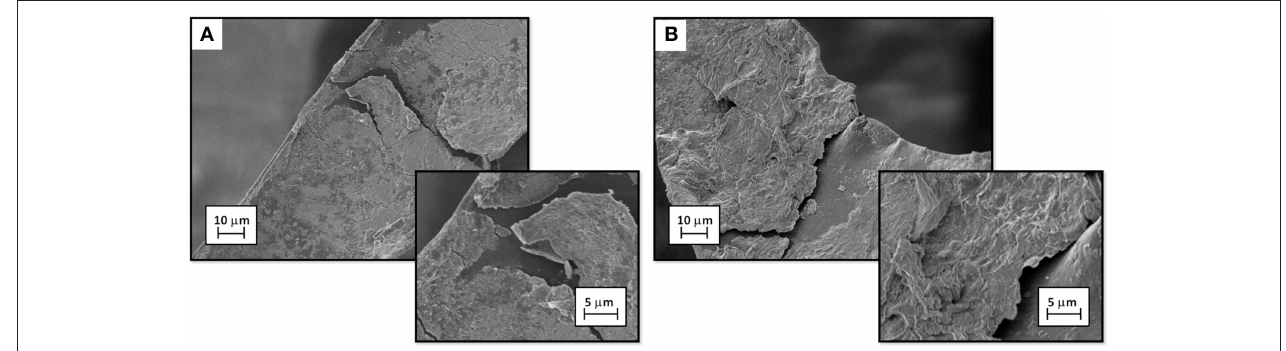
FIGURE 3 | SEM micrographs (main: 1000X, inlet: 2500X) of PU-3L foam after 50 (A) and 100 (B) compression